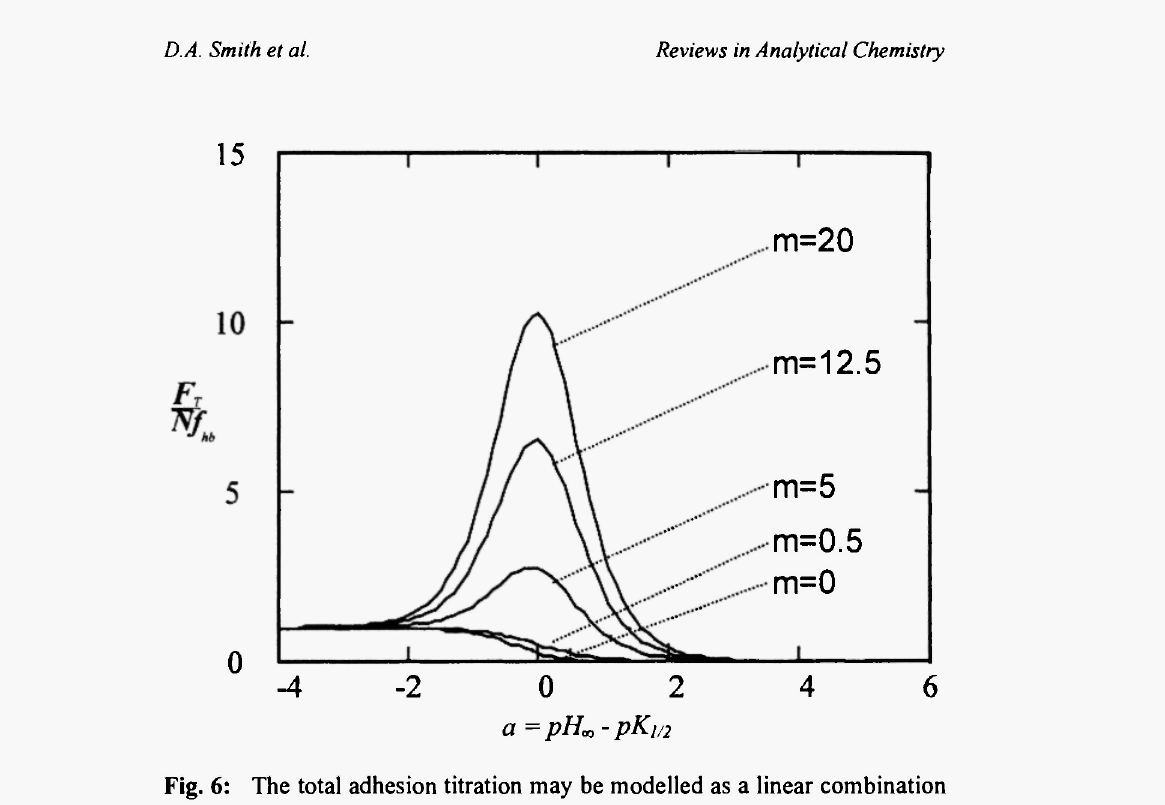
Fig. 6: The total adhesion titration may be modelled as a linear combination of strong ionic and weak neutral hydrogen bonds. The theoretical force titrations produced by this model are plotted for different values of m, the ratio of the strength of these two bonds, and normalised to the product of the number of interacting groups and the strength of a neutral weak hydrogen bond, Nf hh . pH m is the pH of the bulk solution and pKi /2 is defined as the pH m at which half the surface groups are ionised (see equation 3). The shape of the low electrolyte concentration curves are reproduced by values of m~15- 20, whilst the high electrolyte concentration sigmoidal step is reproduced by m = 0 i.e.no strong hydrogen bonds formed (caused by the interaction of buffer ions with the ionised acid groups in the SAMs (see